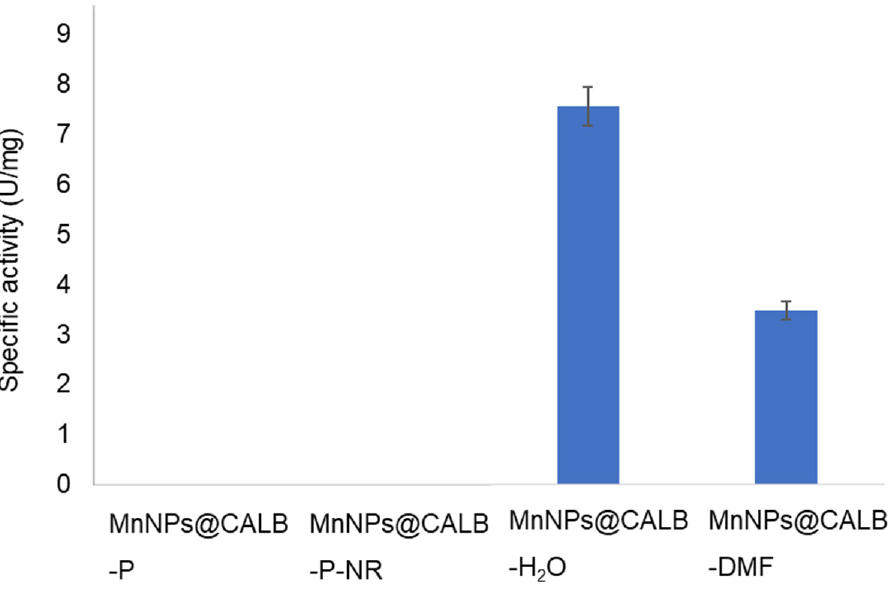
Figure 7. Catalase-like activity of MnNPs@CALB hybrids in distilled water.